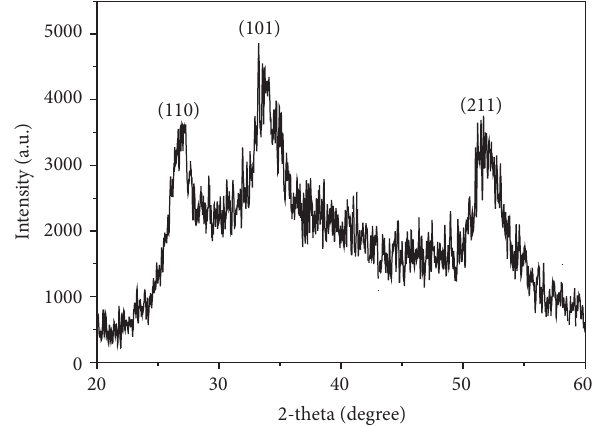
Figure 2: The XRD pattern of the mesoporous SnO 2